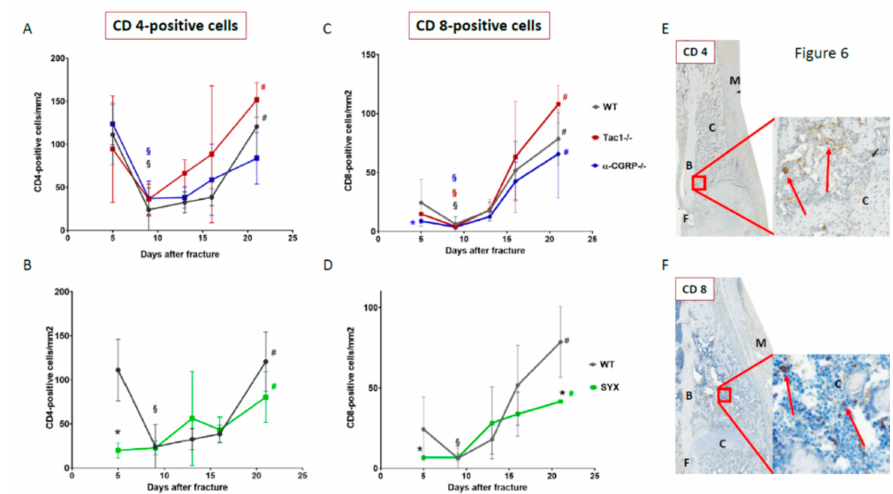
Figure 6. Number of CD4- and CD8-positive cells during callus maturation. Number of CD4-positive helper T cells ( A , B ) and CD8-positive cytotoxic T cells ( C , D ) in the callus tissue of Tac1 − / − , α -CGRP − / − ( A , C ), SYX ( B , D ), and WT mice ( A – D ) at the time points 5, 9, 13, 16, and 21 days after fracture. Number